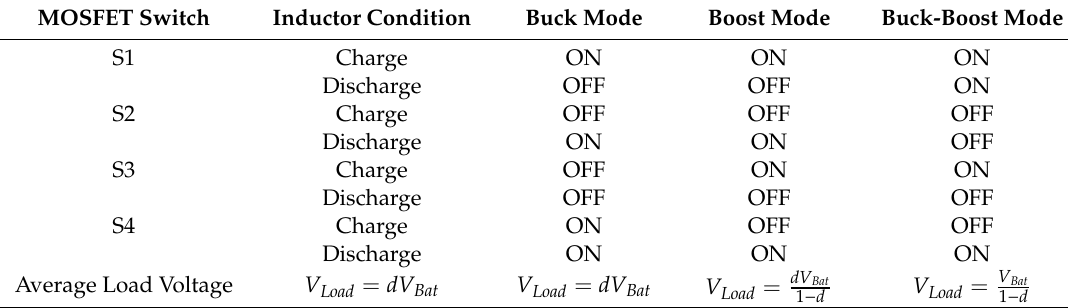
Table 2. Summary of four switched DC/DC Buck-boost converter operation. / DC Buck-boost converter. Figure 7. Four switched synchronous DC/DC Buck-boost converter. Figure 7. Four switched synchronous DC Table 2. Summary of four switched DC / DC Buck-Boost converter operation.